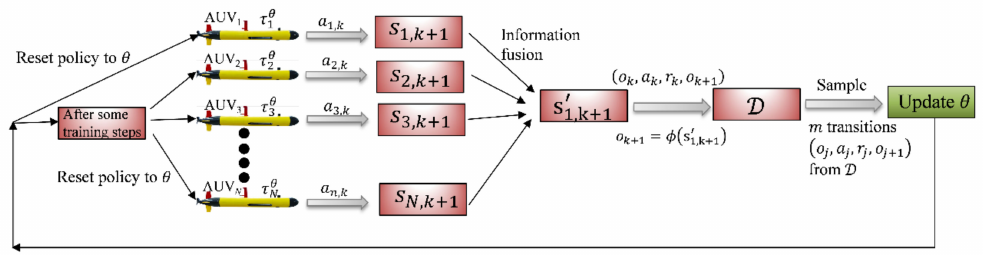
Figure 3. Training framework of the distributed multi-AUVs collaborative search system